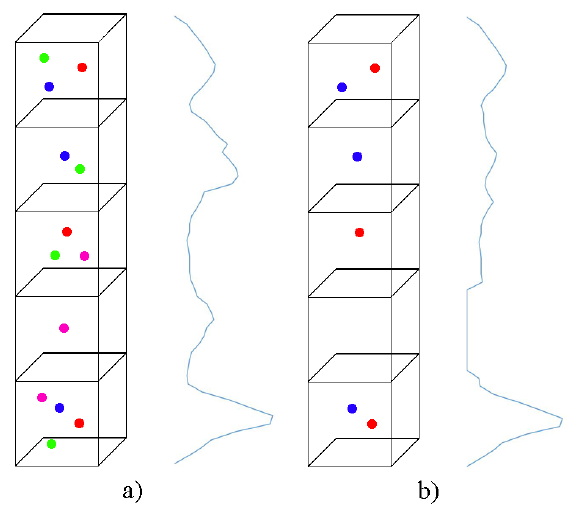
Figure 3. Schematic representation of waveform variability related to point density and maximum value within voxels: ( a ) higher density and ( b ) lower density.